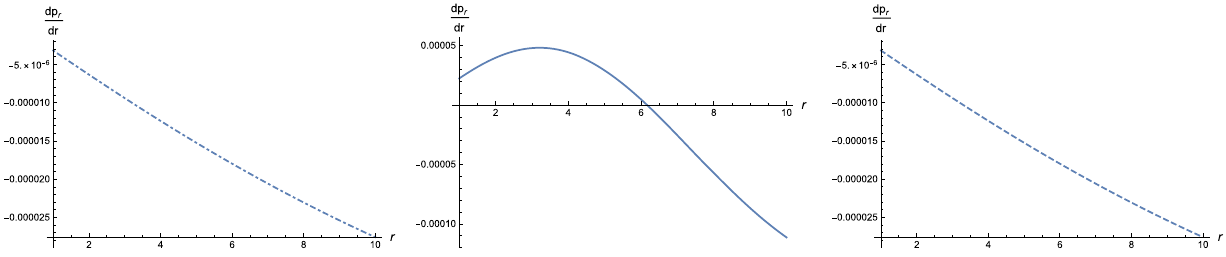
Fig. 5 Variations of d p r with increasing radius of the strange star candidate Her X-1, SAX J 1808.4-3658, and 4U 1820-30; represented by (left d r to right) the first, second, and third graphs,